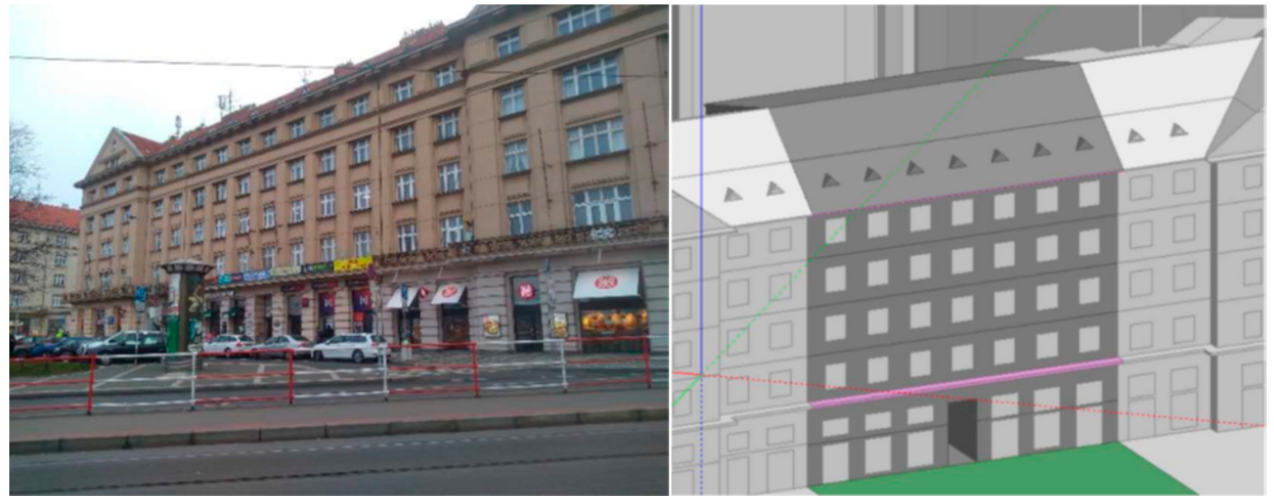
Figure 17. Block of Flats with Parterre. Vít ě zné nám ě stí 577/2, Dejvice, Prague 6, Czech Republic.